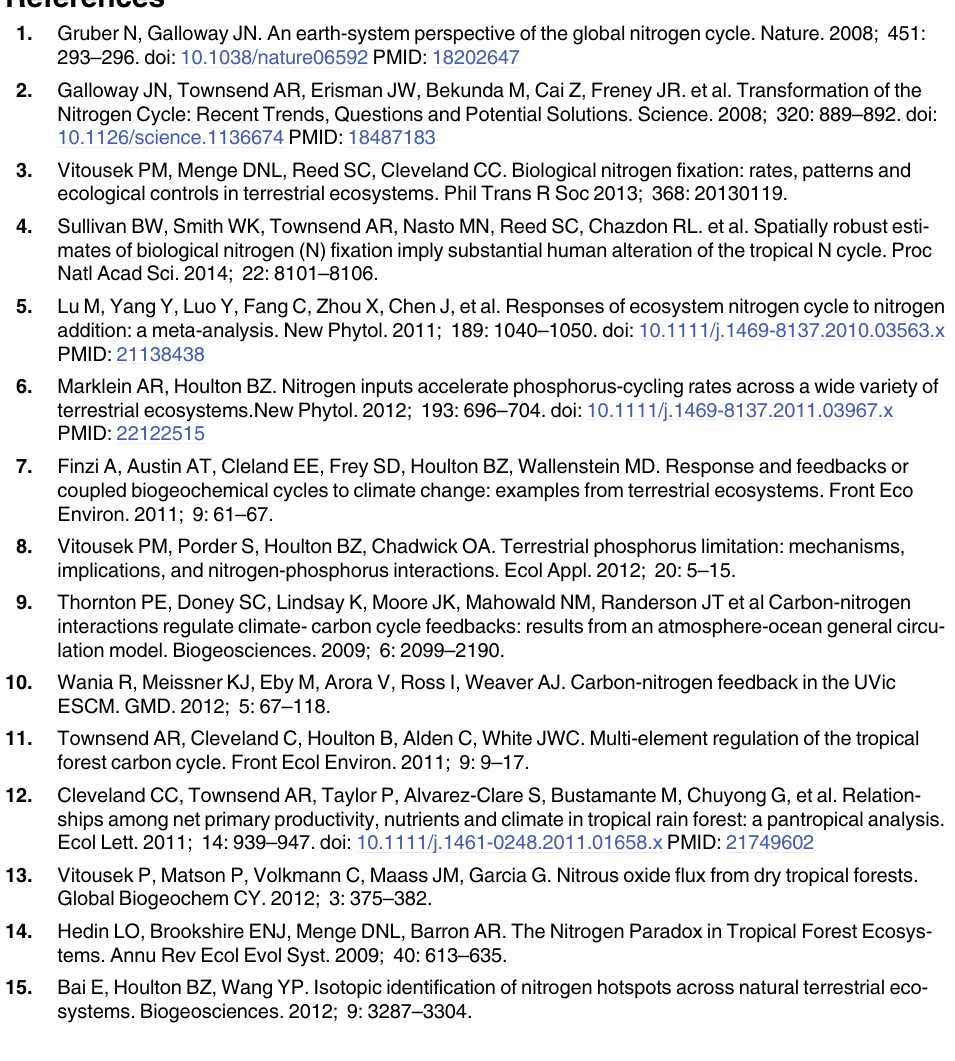
S1 Table. 35 response variables considered in this